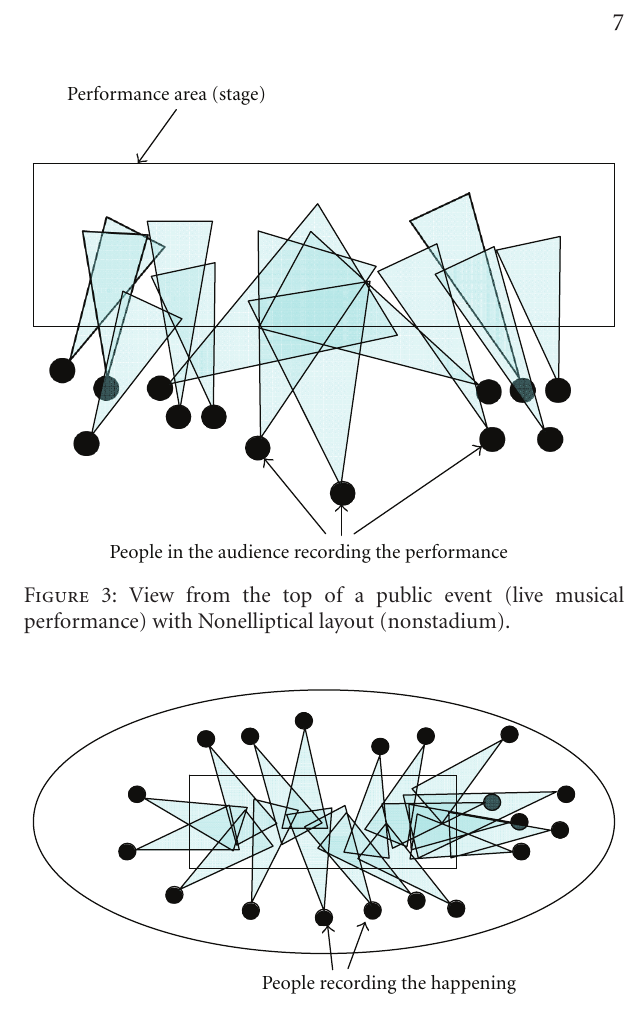
Figure 4: View from the top of a public happening (sport) with elliptical layout